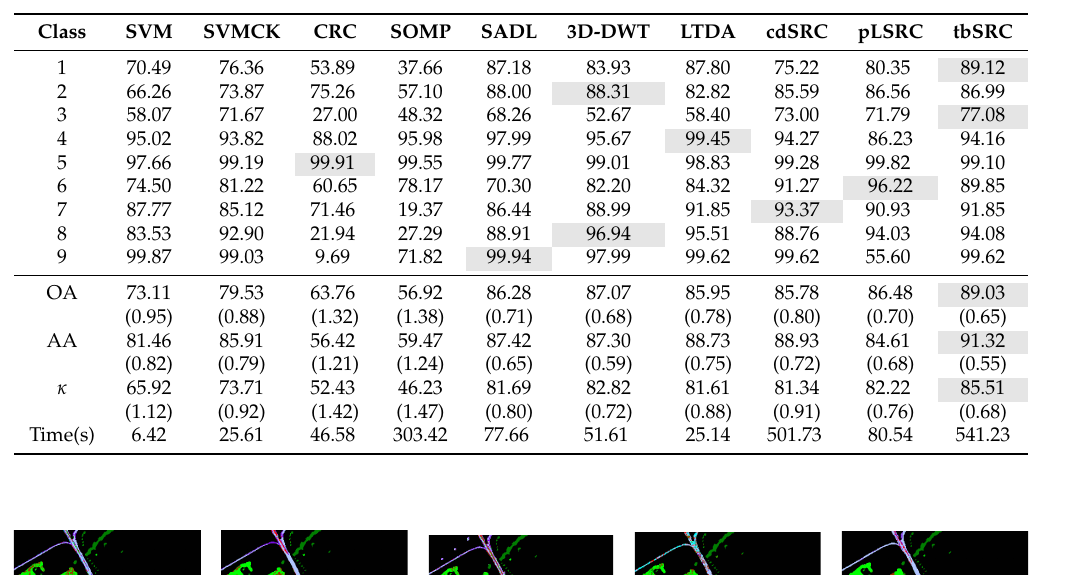
Table 3. Classification accuracy (%) and standard deviation (in bracket) of different methods for the University of Pavia Data.